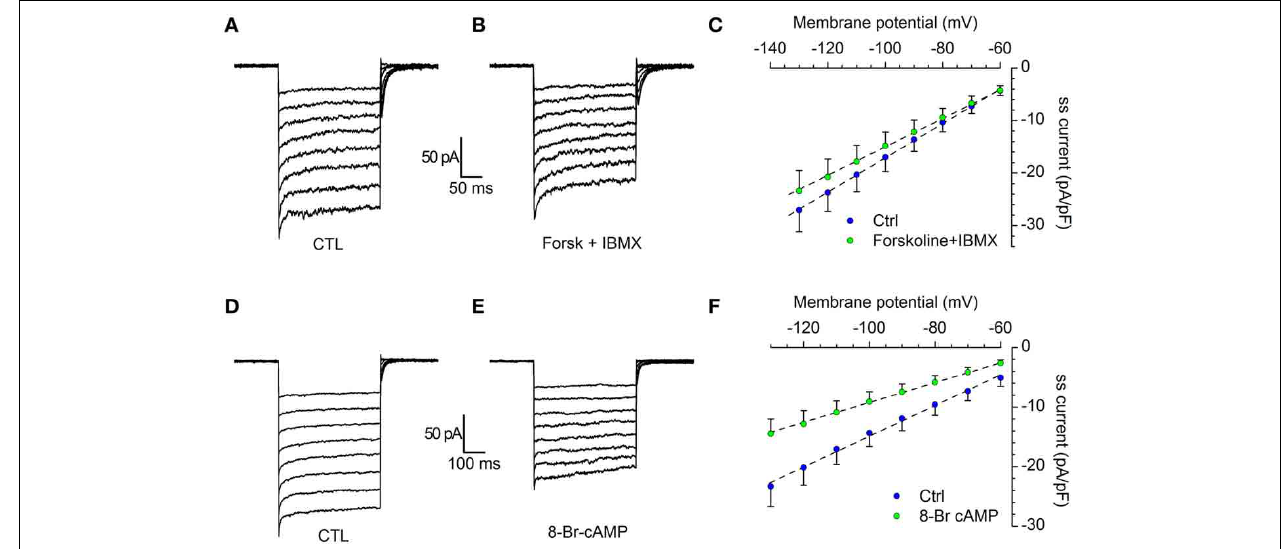
FIGURE 8 | Modulation of I Kir by cAMP. (A–C) Effect of forskolin. Current tracings in control (A) and in the presence of 10 μ M forskolin plus 100 μ M IBMX (B) ; (C) comparison of the I/V curves recorded in control (blue dots) and forskolin (green dots); n = 12; the difference, tested with Two-Way ANOVA and post-hoc Bonferroni test, is significant for the potentials more negative than − 80mV. (D–F) Effect of